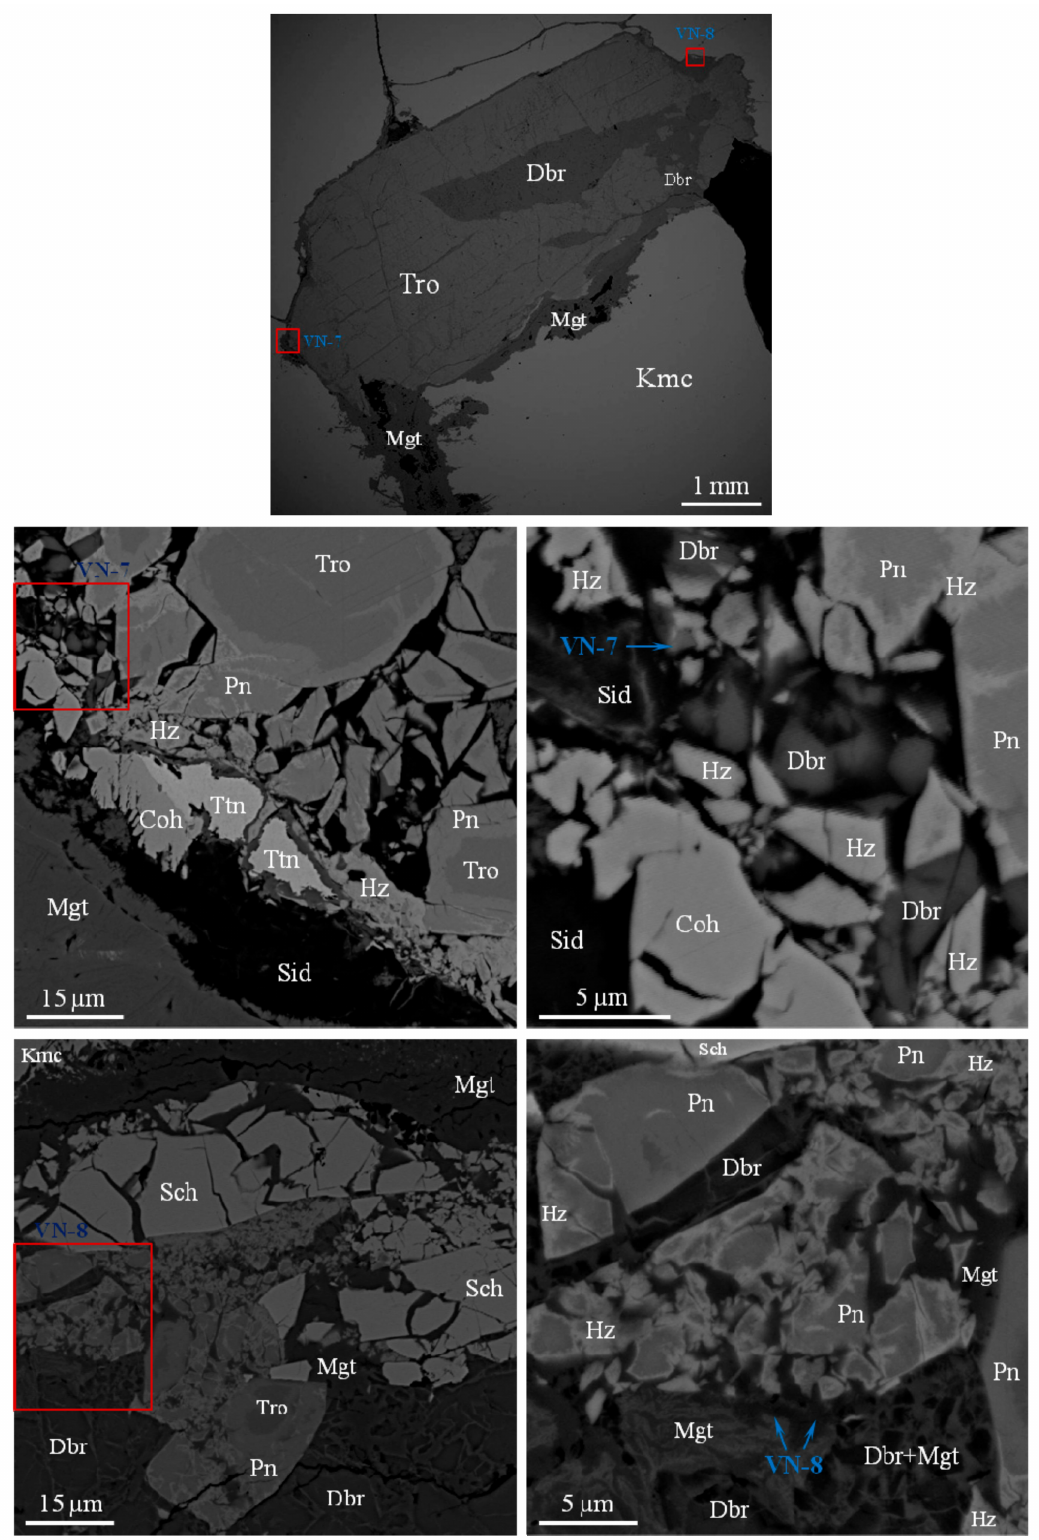
Figure 7. Uakitite in a large troilite–daubr é elite nodule, Uakit meteorite (IIAB), BSE images. Symbols: VN-7, VN-8—uakitite; Dbr—daubr é elite; Tro—troilite; Sch—schreibersite; Mgt—magnetite; Kmc—kamacite; Pn—pentlandite; Hz—heazlewoodite; Coh—cohenite; Ttn—tetrataenite;